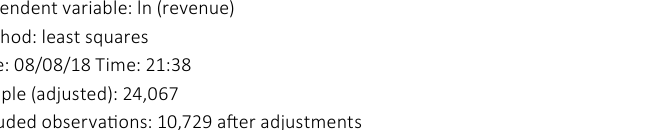
Table A3. Estimation result of model (2) with D